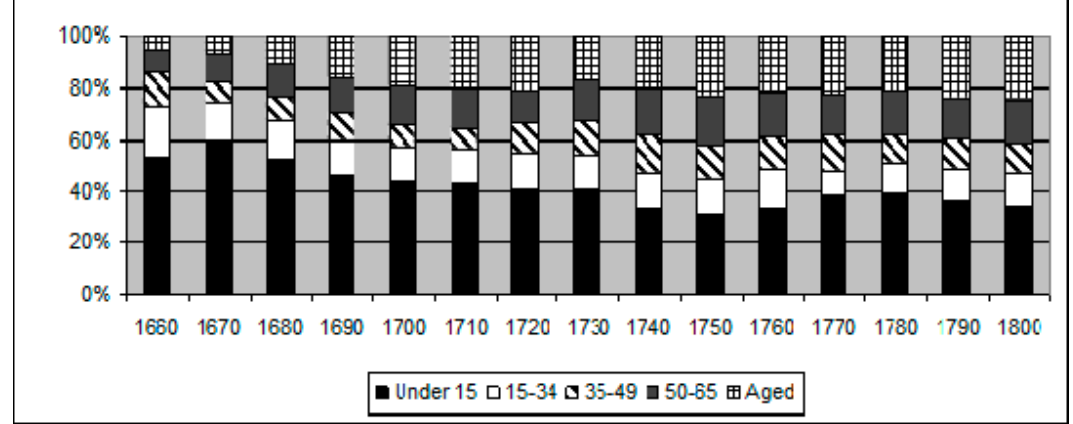
Figure 4. Age structure of L&M QM burial registers.